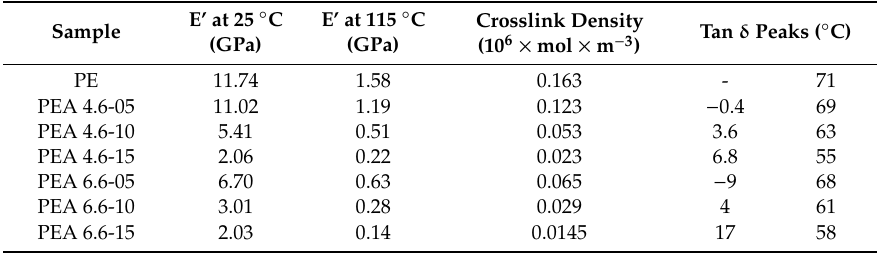
Table 4. DMA results of the cured